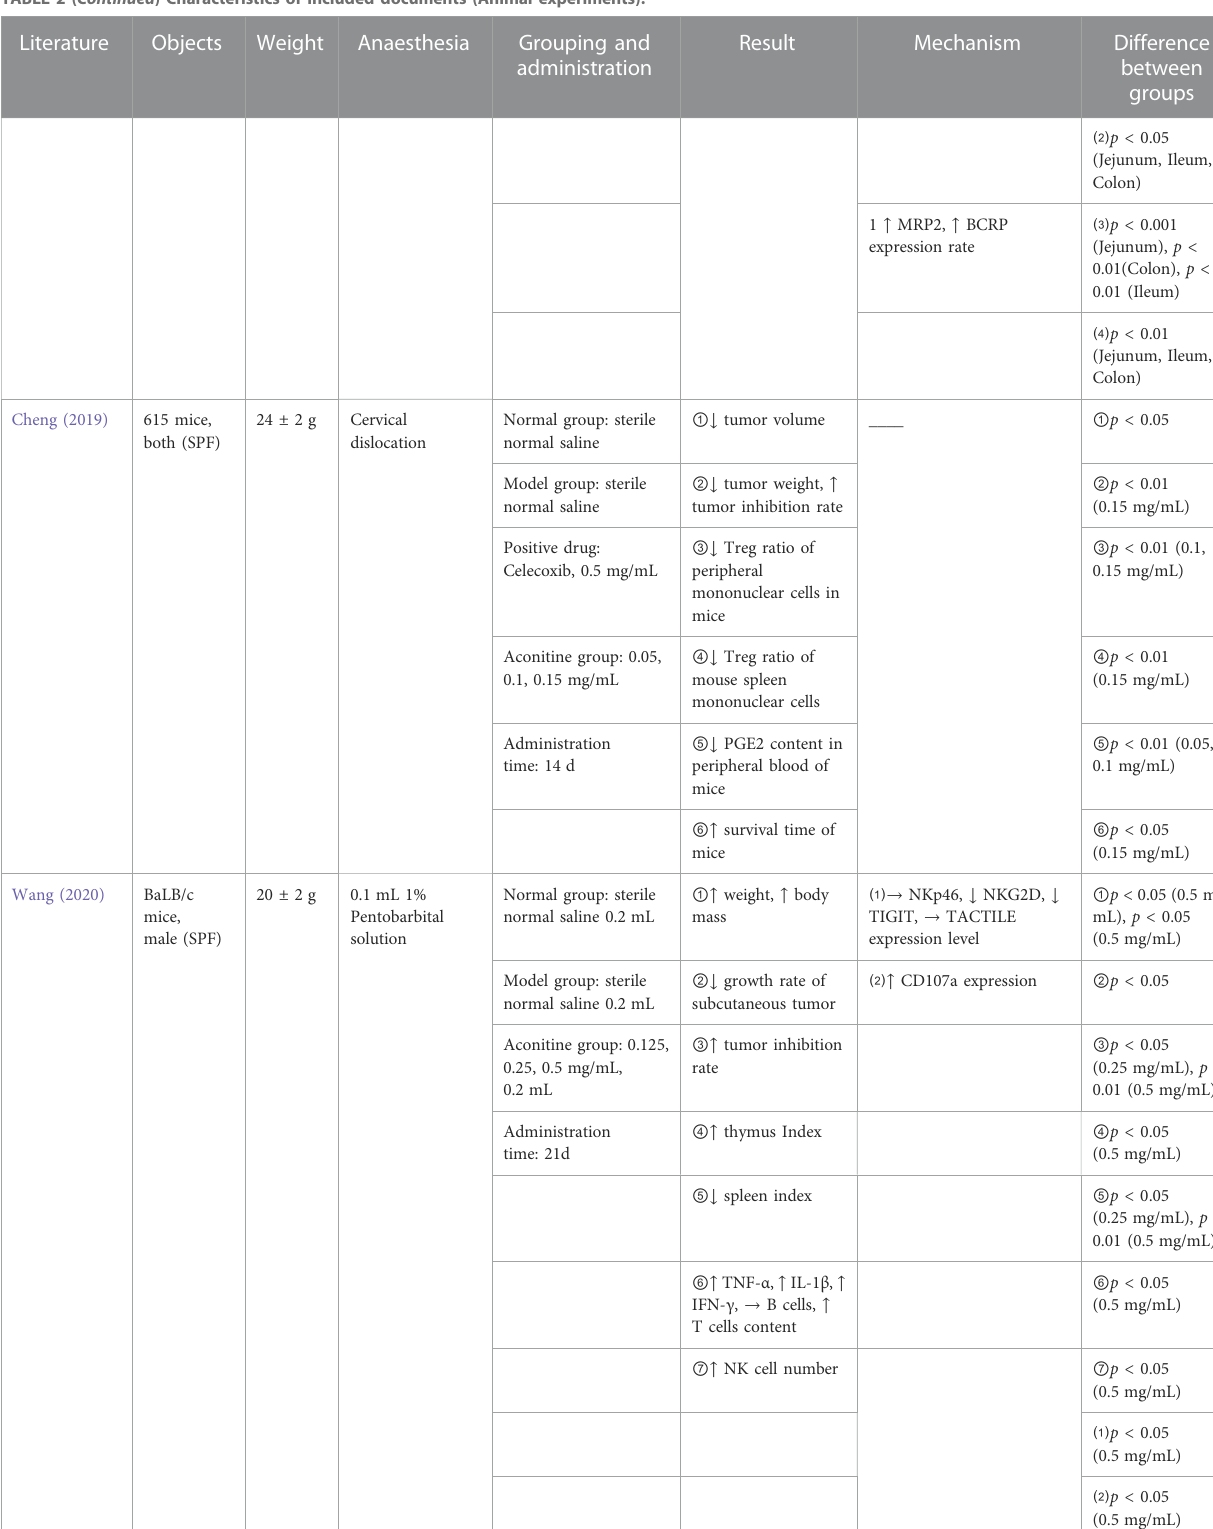
a random effects model. The results indicated a signi fi cant difference between the control and experimental groups ( Z = 3.84, p = 0.0001) with a 95% con fi dence interval of [MD = − 0.64, 95% CI ( − 0.97, − 0.31)]. This indicated that aconitine could reduce